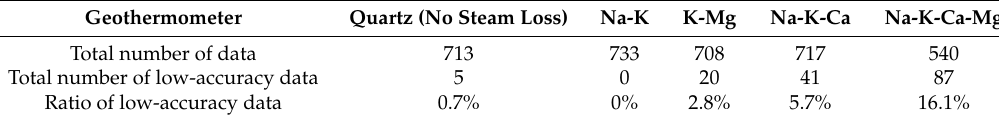
Table 2. Total number of data used for the calculation by the major solute geothermometers, total number of low-accuracy data, and the ratio of low-accuracy data. Low-accuracy data indicate data in which reservoir temperatures estimated by the geothermometers were lower than the spring temperatures.